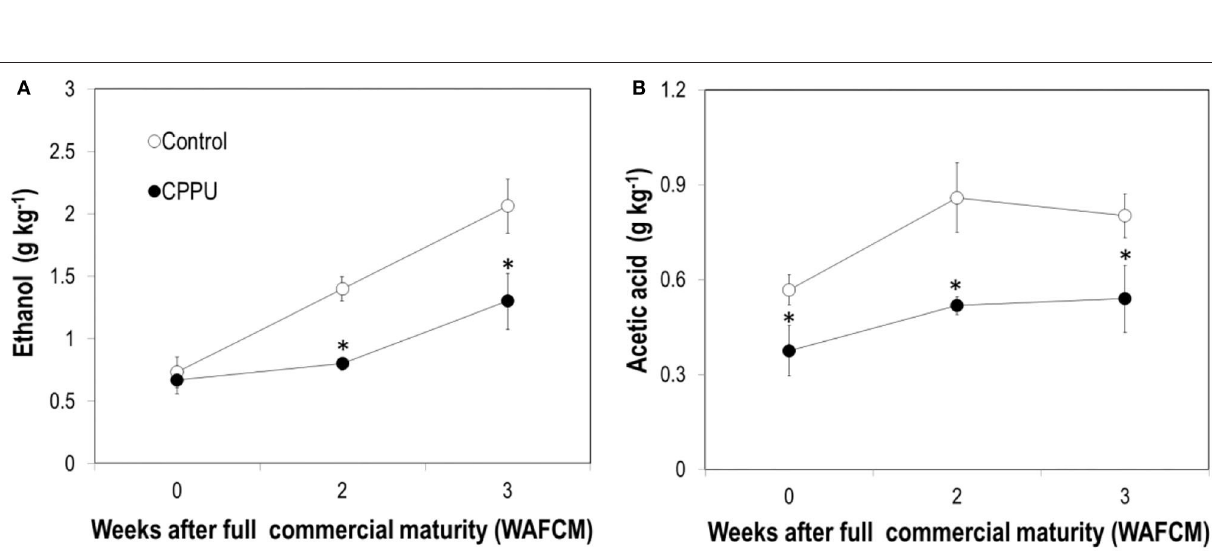
Frontiers in Plant Science |